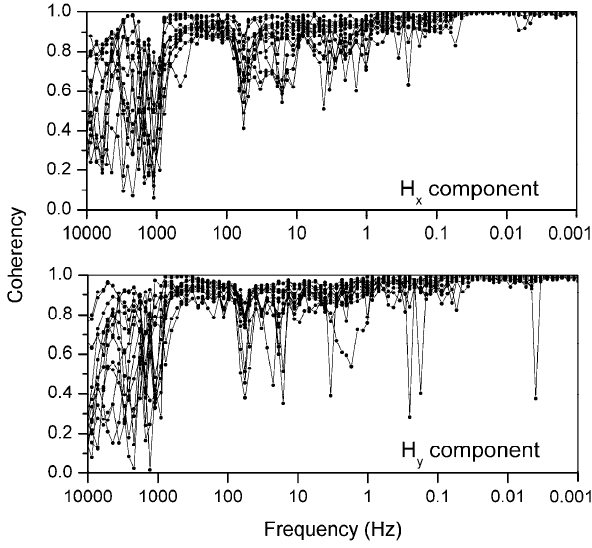
Fig. 6. Coherency between the 14 individual MT sites and their Figure 6. reference sites as a function of frequency for the horizontal geo- magnetic components H x (top) and H y